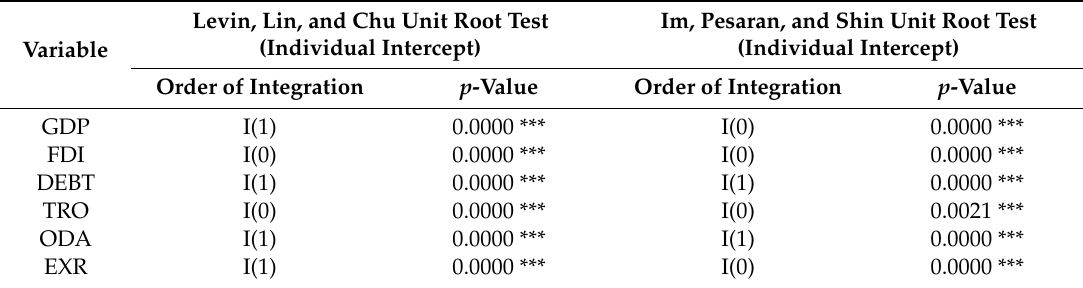
Table 1. Levin, Lin, and Chu (LLC) and Im, Pesaran, and Shin (IPS) panel unit root tests for the low-income group.